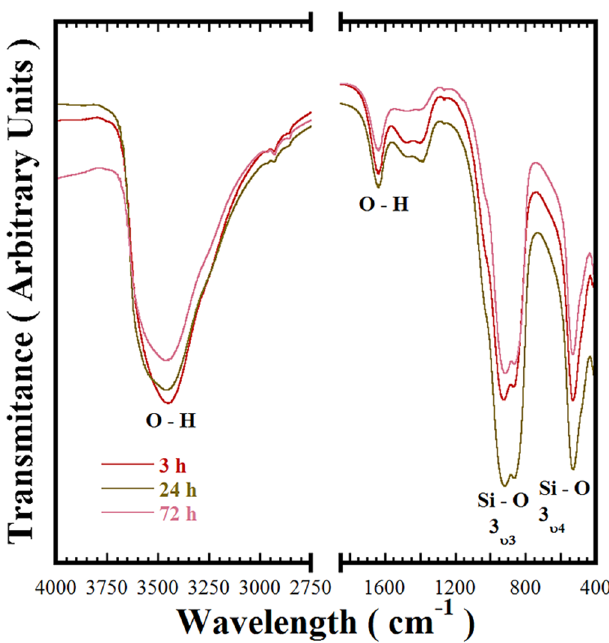
Figure 3. Fourier transform infrared (FT-IR) spectrum of Ca 3 Cr 2 Si 3 O 12 pigment samples hydrothermally crystallised at 200 °C using a 5.0 M KOH solution (12.5 mL), the stoichiometric mixed Si 4+ content used was 3.0 mole, and all the treatments were conducted without stirring for various reaction intervals as shown.